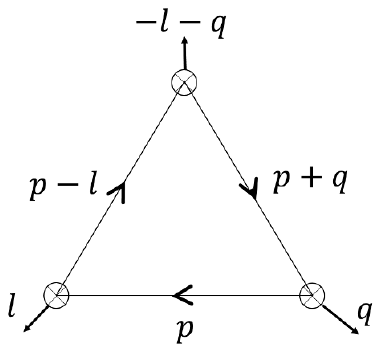
Figure 10. Diagrams contributing to